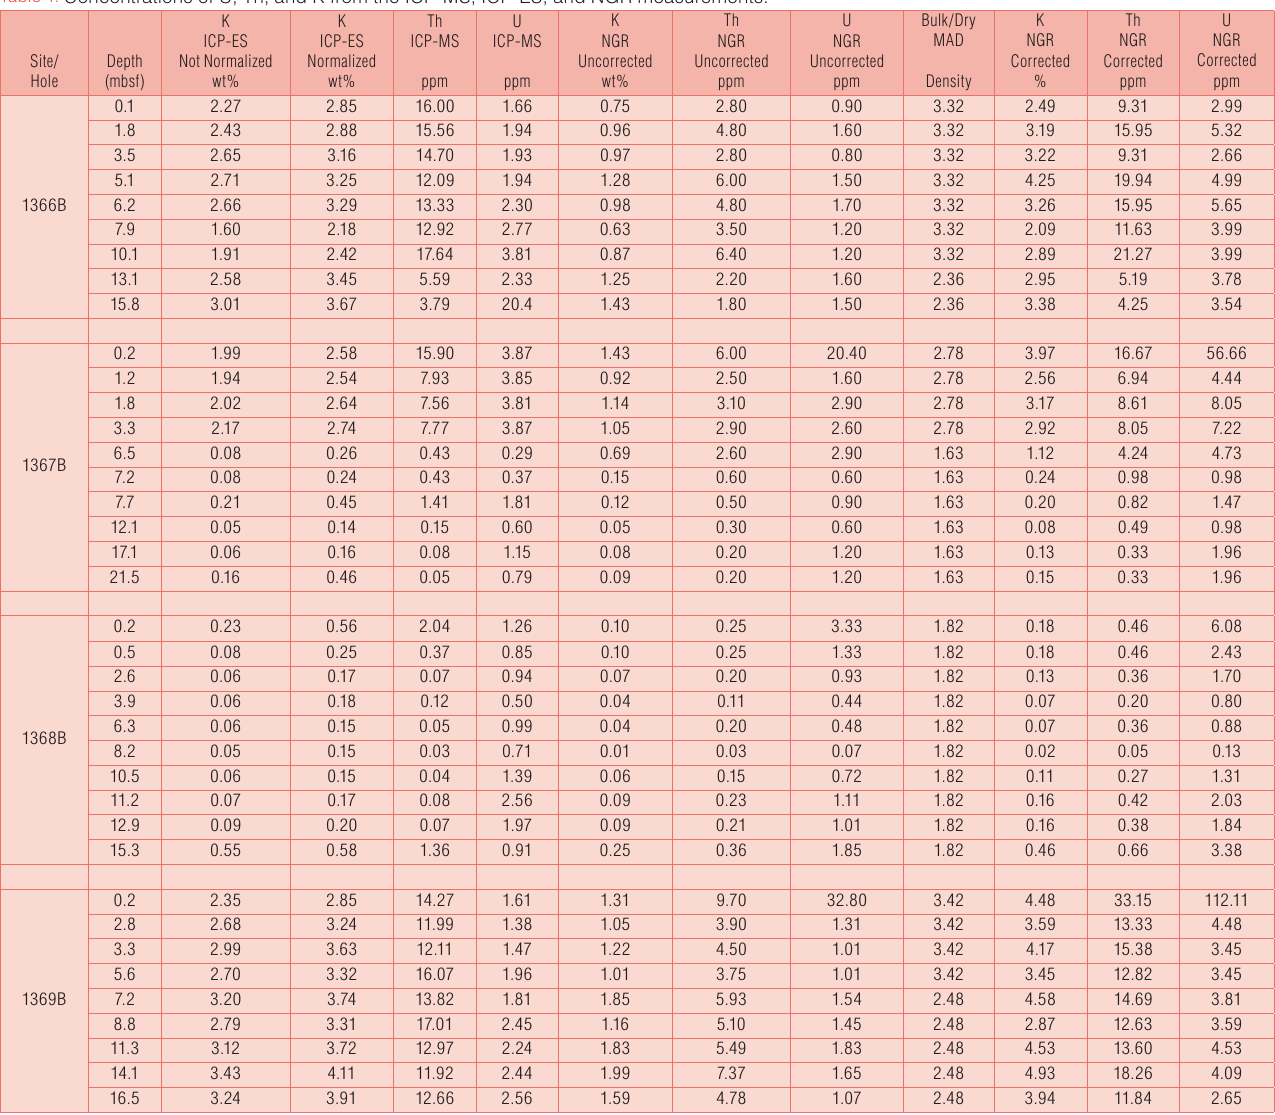
Table 1. Concentrations of U, Th, and K from the ICP-MS, ICP-ES, and NGR measurements.